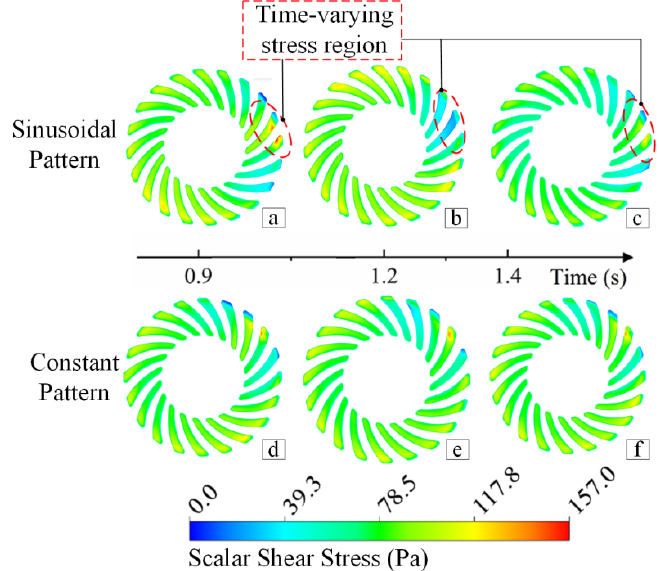
Figure 16. Shear stress variation characteristics of sinusoidal and constant speed patterns at different moments. Red dotted frames in panels ( a – c ) show the time-varying characteristics of scalar shear stress in the sinusoidal speed pattern; panels ( d – f ) show that the amplitude and distribution of scalar shear stress were almost unchanged in the constant speed pattern.